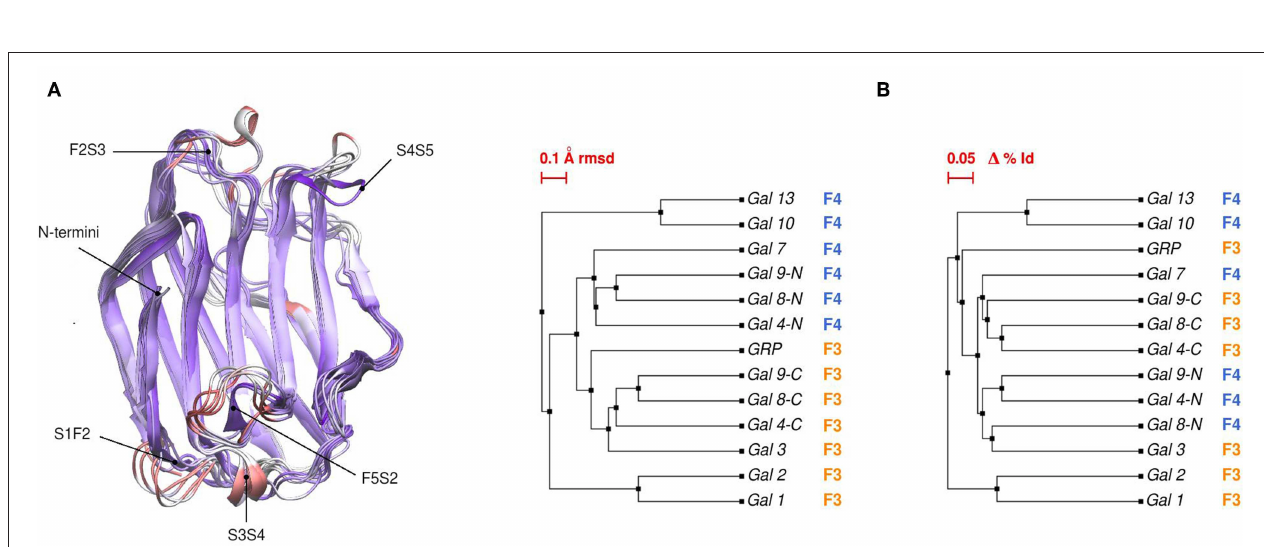
FIGURE 2 | (A) Structural alignment of all available human Galectin CRDs X-ray structures. Blue-colored regions correspond to the lowest RMSD values and red to the highest values. Gal-1 structure used as reference. Each loop is named after the two β -strands it connects. (B) Backbone RMSD-based tree (left) and amino acid sequence identity tree (right) of the X-ray